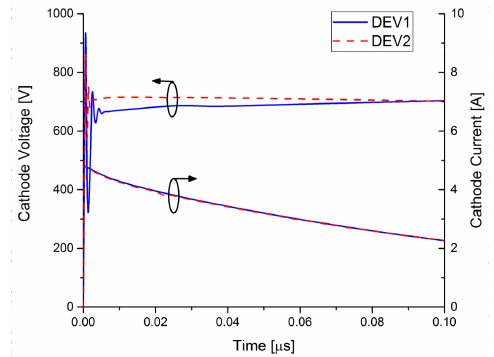
Figure 11. Cathode voltage and current waveforms of DEV1 and DEV2 structures during the ESD test simulation (termination area included).